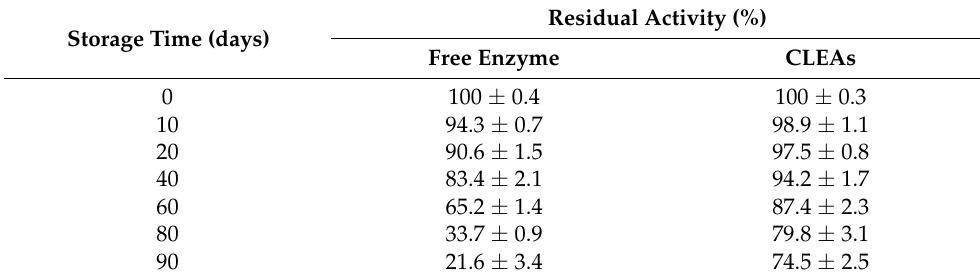
Table 2. Storage stability of Aga-CLEAs at 4 ◦